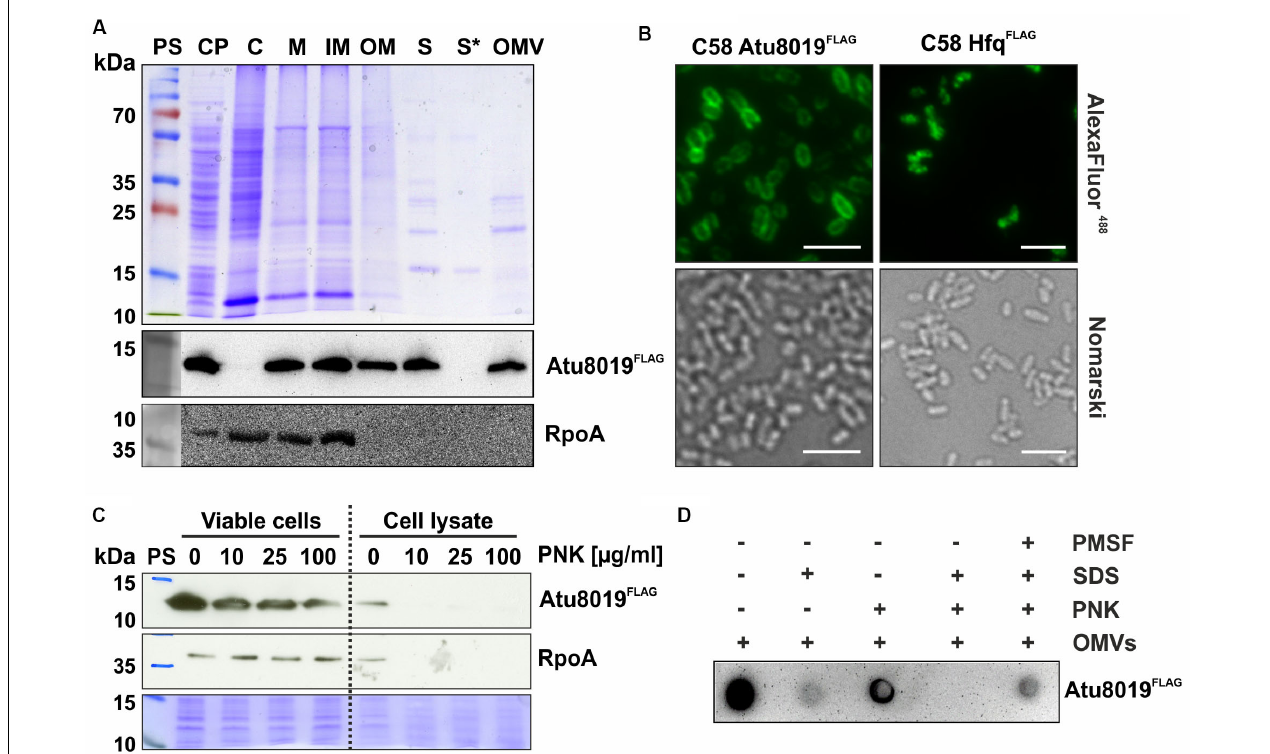
FIGURE 3 | Localization of Atu8019 FLAG in A. tumefaciens . (A) SDS-PAGE and Western blot analysis of different cell fractions from the Atu8019 FLAG reporter strain. Cells were cultivated in LB medium until stationary growth phase. The cell pellet (CP) was resuspended in buffer and cells were disrupted and separated into cytosolic (C) and membrane fractions (M) by ultracentrifugation. The membrane fraction was treated with N -lauroylsarcosine to separate it into inner and outer membranes (IM/OM). For the extracellular localization of proteins, the cell-free culture supernatant (S) was fractionated into secreted soluble proteins (S*) and OMV-associated proteins (OMV) by ultracentrifugation. Atu8019 FLAG was detected with anti-FLAG antibodies and RpoA, detected by a specific antibody, served as a cytoplasmic, and inner-membrane reference protein. (B) Immunofluorescence imaging of Atu8019 FLAG . Hfq FLAG served as cytosolic reference protein. Scale bars: 5 µ m. (C) Surface exposure of Atu8019 FLAG in cells. Proteinase K (PNK)-protection assays were performed with viable and lysed Atu8019 FLAG reporter strain cells to determine the orientation of Atu8019 in the outer membrane. (D) Surface exposure of Atu8019 in OMVs. PNK-protection assay and Dot blot with intact and SDS-treated OMVs isolated from an Atu8019 FLAG reporter